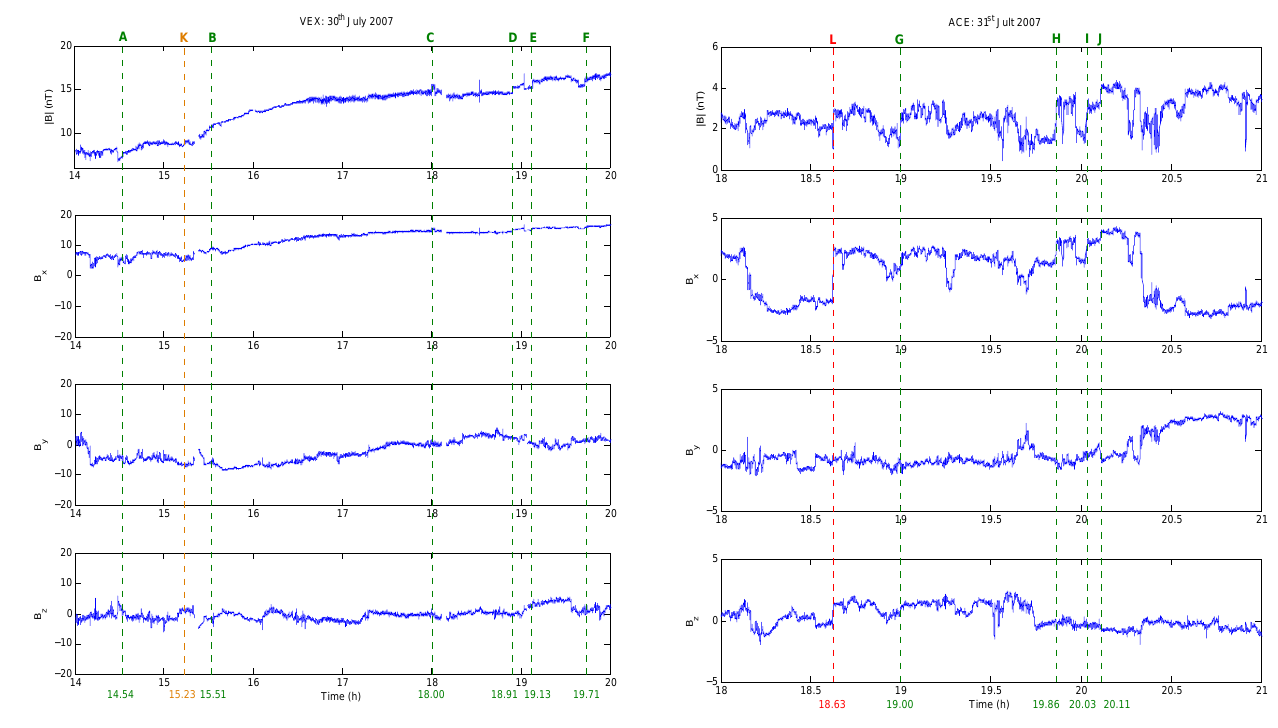
red dotted lines represent some examples of nonlinear struc- tures that did not fulfil the criteria for a shock crossing. Ta-